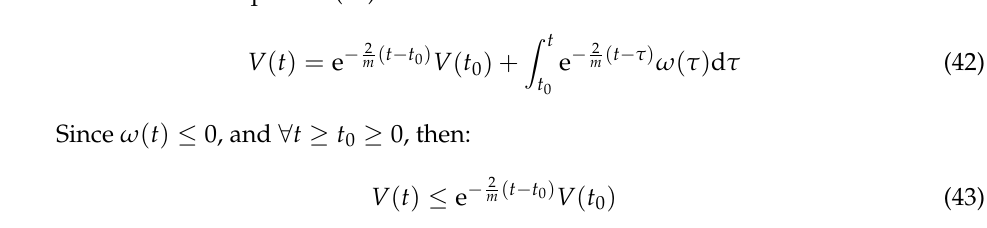
Figure 8. Comparison of curve tracking under SMC and PID algorithms